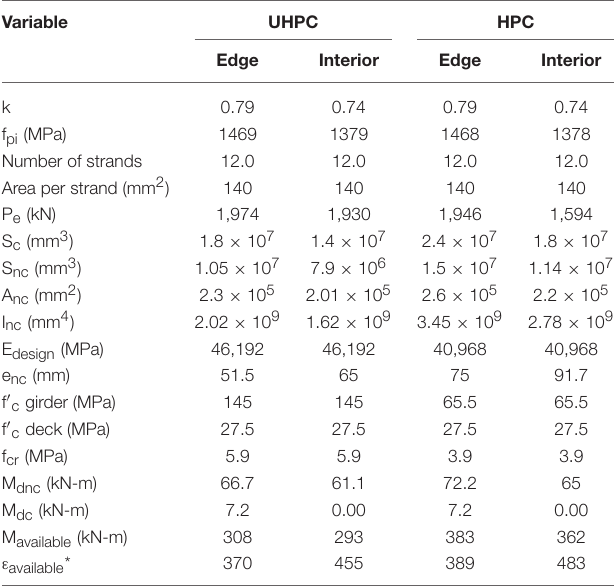
TABLE 1 | UHPC and HPC available moment and strain parameters.